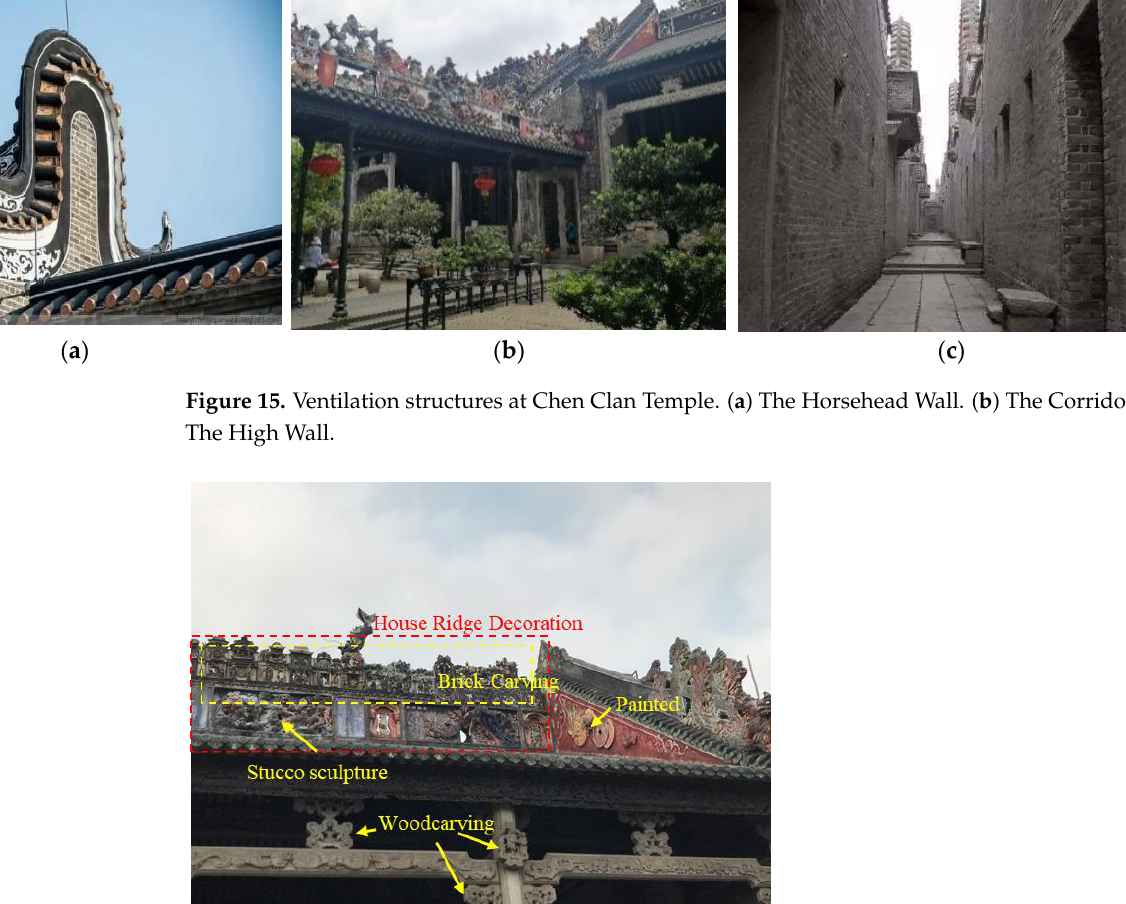
Figure 14. The Chen Clan Temple.